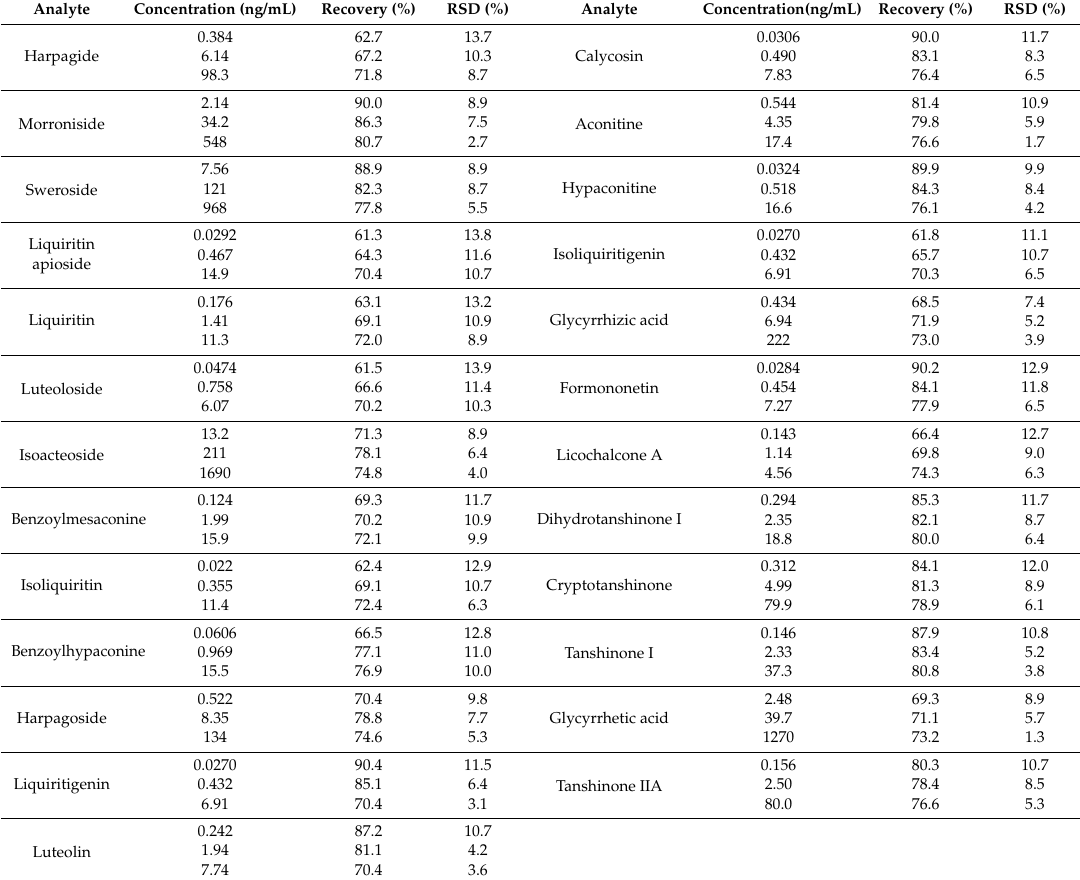
Table 4. Recovery data for the twenty-five analytes ( n =